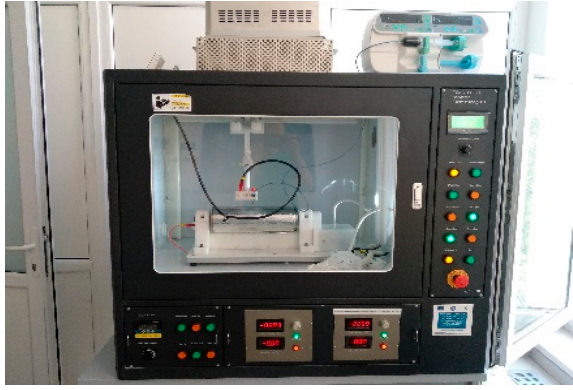
Figure 2. Electrospinnig